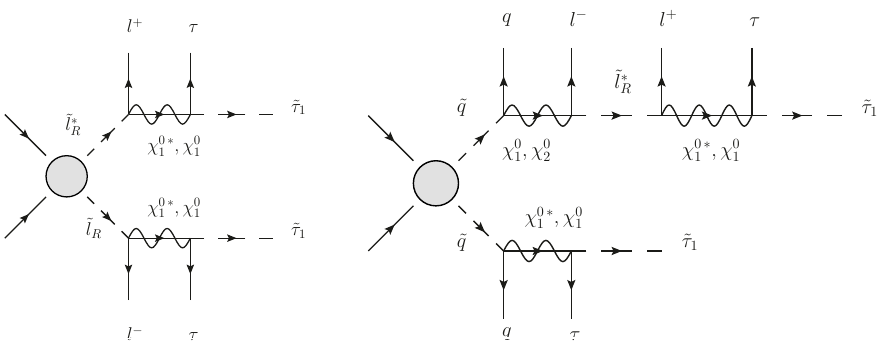
Figure 1 . Representative diagrams for the Drell-Yan production of ~ l R is shown in the left. The right panel illustrates a SUSY cascade process initiated by SUSY particles from the strong sector that mimics the (cid:12)nal state of the left panel, modulo hard